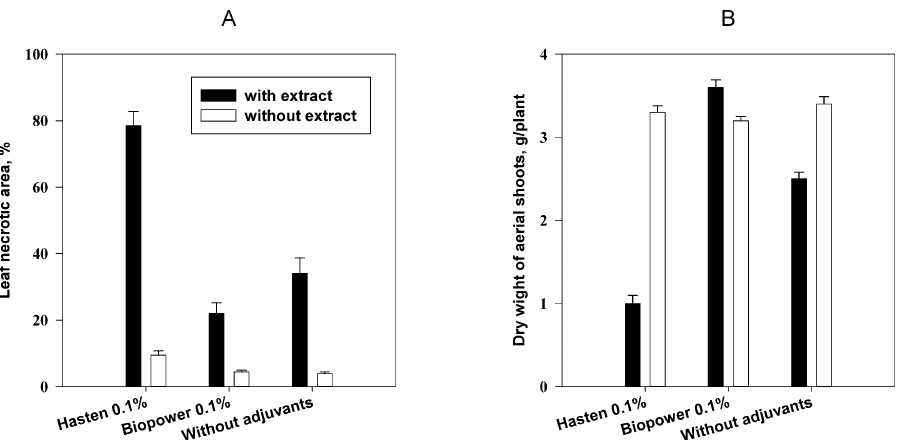
Figure 6. Effect of adjuvants on herbicidal activity of 0.5% semi-purified extract from solid culture of Paraphoma sp. VIZR 1.46 on C. arvense plants 48 h after treatment: ( A ) level of leaf damage (LSD 0.05 = 11.0), ( B ) dry biomass of aerial shots (LSD 0.05 = 1.8), bars indicate standard deviation at p = 0.05.